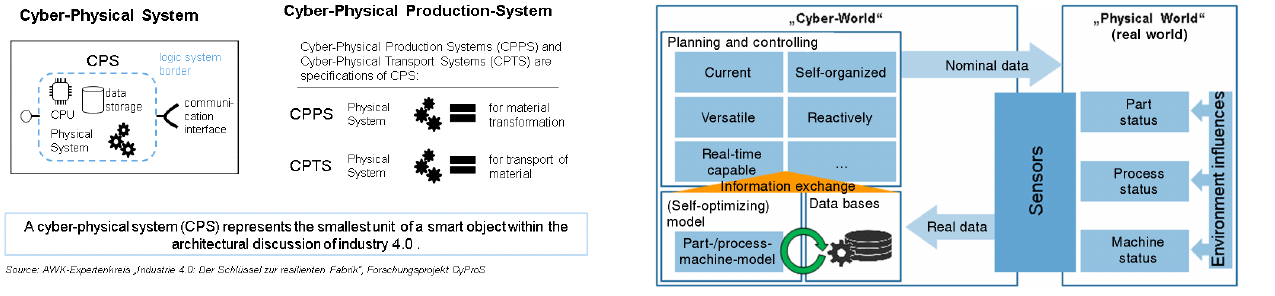
Figure 2. Concept of a cyber-physical production